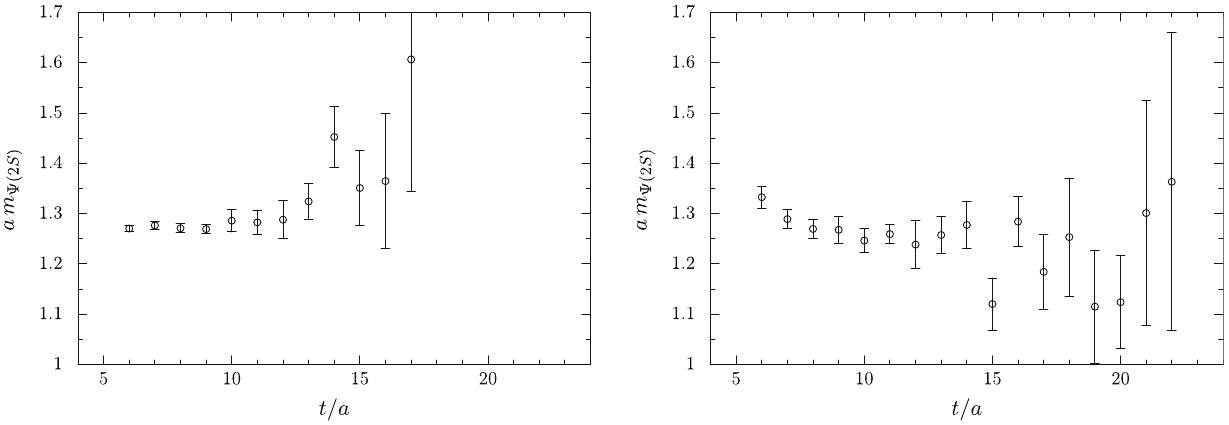
computed using either a fixed time t fix (left plot) or a running time t VV